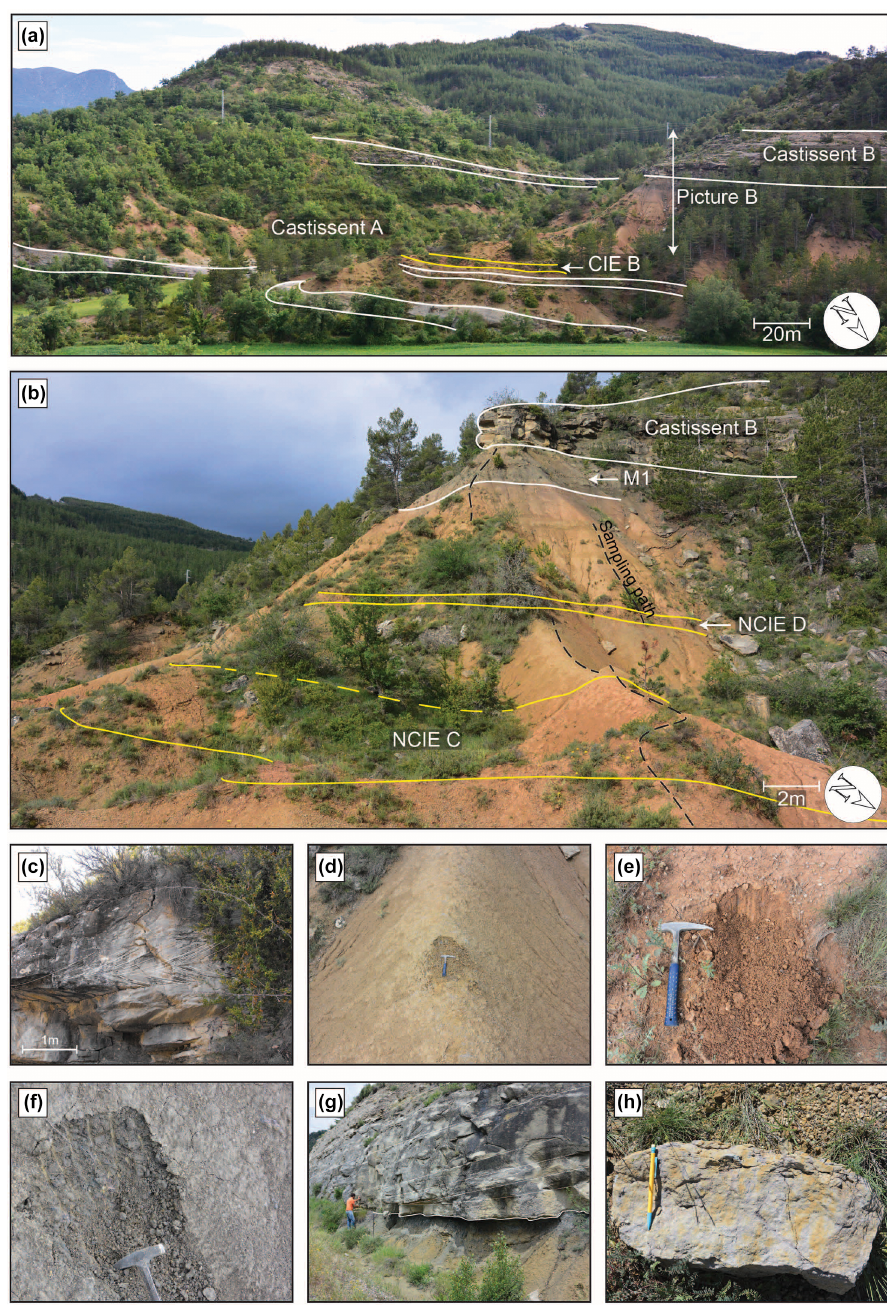
Figure 4. Field images of the Chiriveta section (42 ◦ 7 (cid:48) 56.57 (cid:48)(cid:48) N, 0 ◦ 41 (cid:48) 19.45 (cid:48)(cid:48) E). (a) Outcrop view of Members A and B of the Castissent Formation. (b) Close-up view of the upper part of Castissent A Member. Fluvial channel-fill deposits, intercalated in reddish floodplain and overbank deposits and regional marine incursions (M1). (c) M0, first marine incursion at the base of the Castissent Fm. described by Marzo et al. (1988) expressed in the Chiriveta section by a tidal-influenced coarse sandstone with herringbone cross-stratification. (d) Yellow mottled palaeosol between CIE C and D. (e) Red floodplain interval equivalent of the CIE C. (f) 2m thick grey interval interpreted as poorly drained brackish water facies and equivalent to the marine incursion M1. (g) An ∼ 6m thick laterally extensive Castissent B sandbody incised in the underlying floodplain deposits. (h) Mottled silt, interpreted as pedogenetic fluvial channel overbank